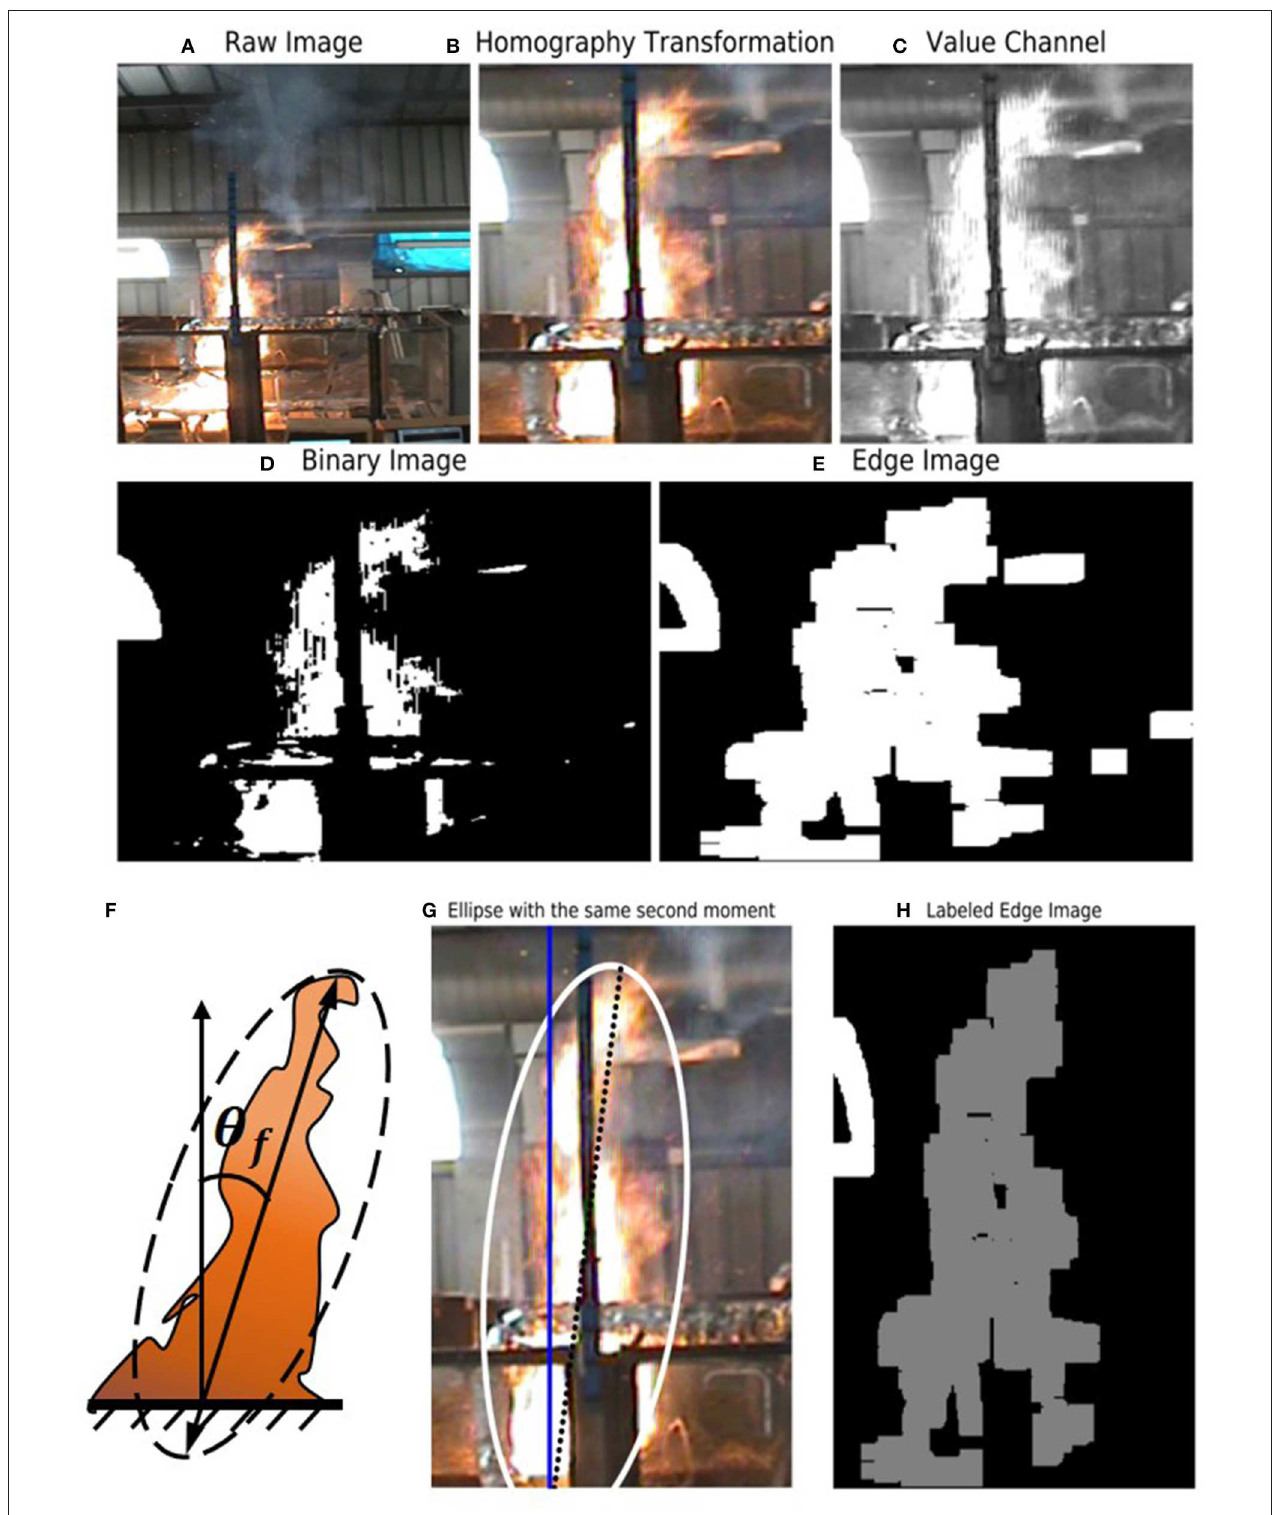
FIGURE 2 | Flame tilt computer vision algorithm image processing steps and schematic (clockwise from the leftmost top corner): (A) raw image (B) homographic transformation (C) value channel extraction (D) binary image (E) edge image (H) labeled edge image (G) ellipsoid generated from the processed image overlapped in RGB raw image (F) schematic with flame length and flame tilt angle labeled.